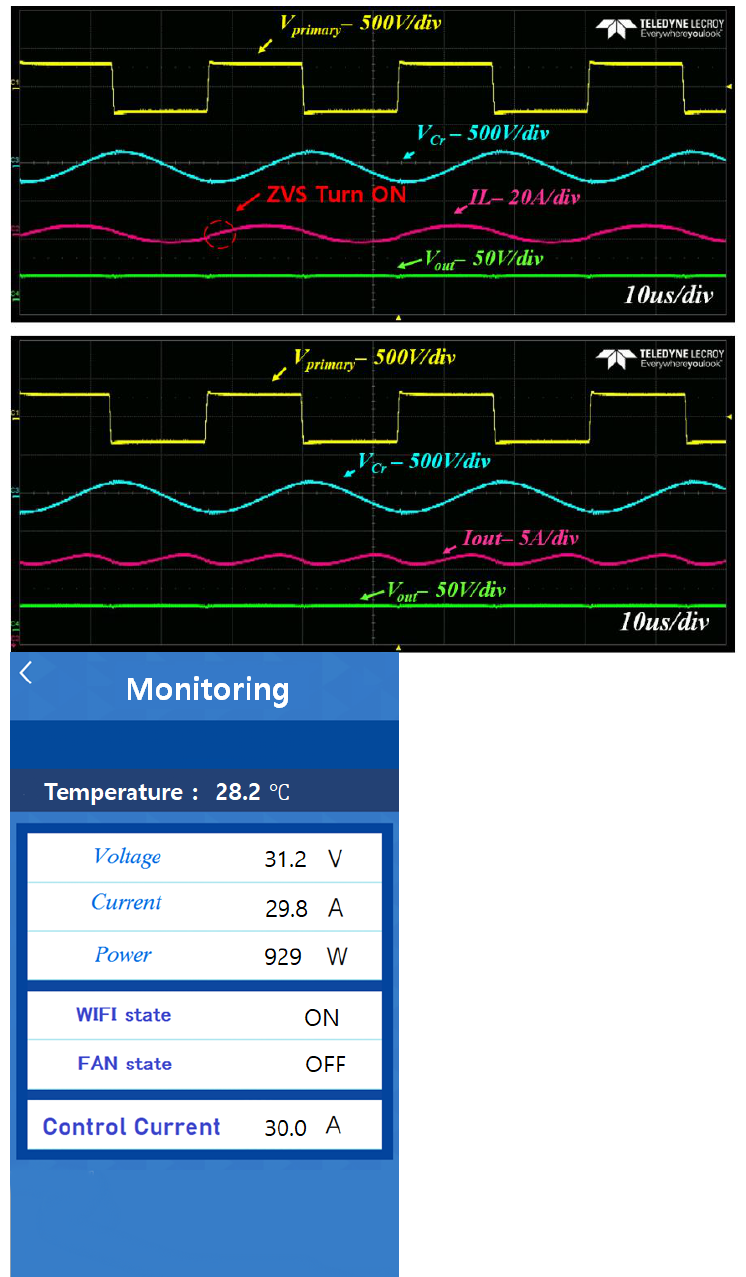
Figure 9. Charging wave form and corresponding smartphone application screen snapshots (Fast Charging mode, Temperature = 29.1 °C.